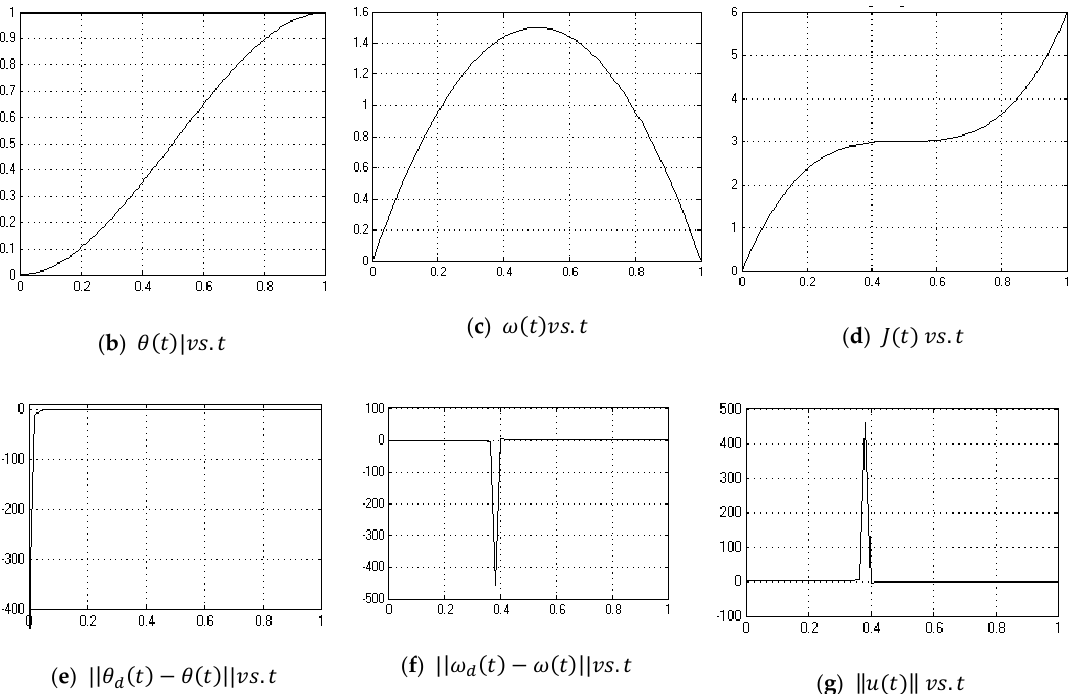
Figure A5. Continuous predictive optimum controlled simulation model.